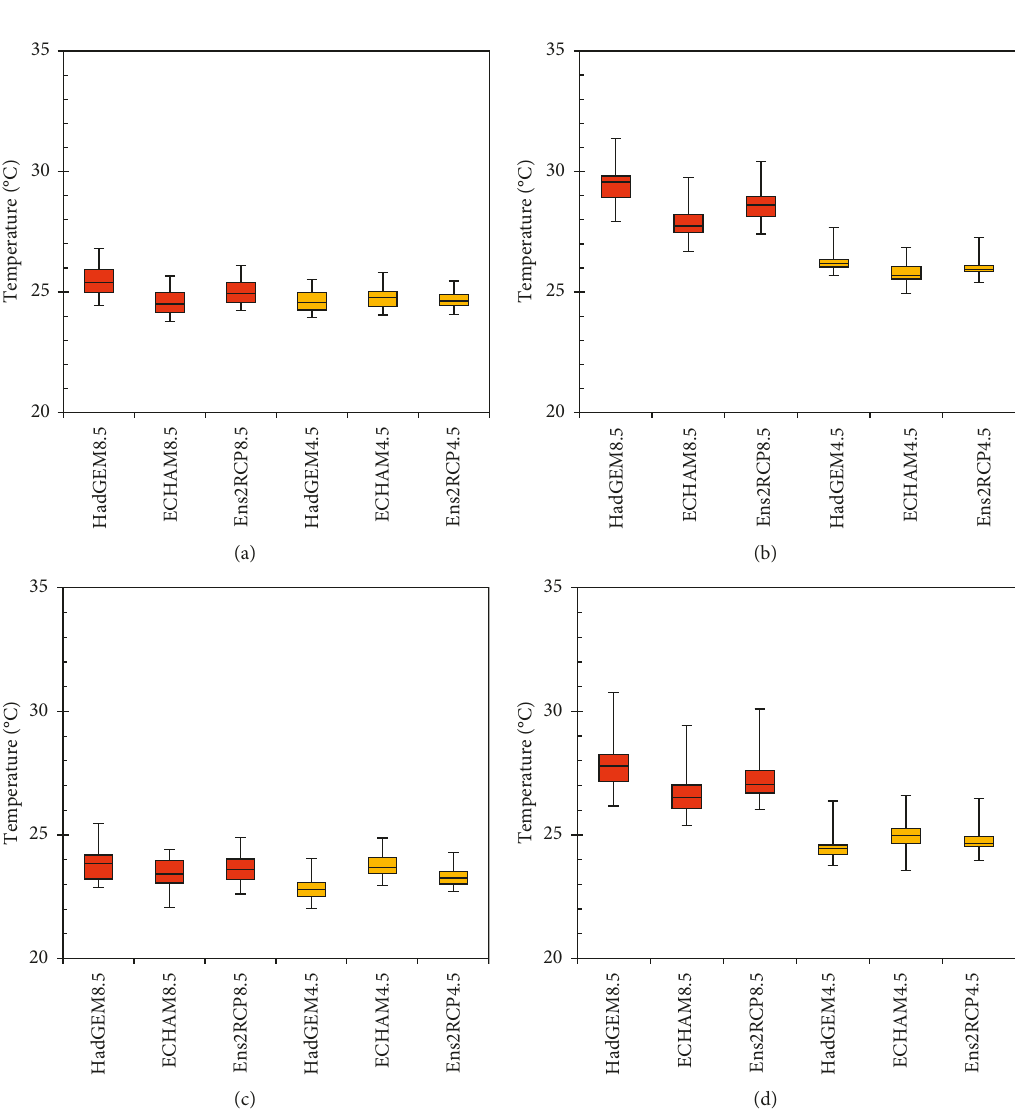
Figure 5: Box plots of RegCM4-simulated air temperature (in ° C) for each model and RCPs for near future and far future averaged over 11 subdomains for CORDEX-MENA/Arab domain (a, b) and subdomain over the Arabian Peninsula (c, d). The Ens2RCP8.5 and EnsRCP4.5 represent the average from HadGEM and ECHAM for the RCP8.5 and RCP4.5, respectively. The red boxes are for RCP8.5 and yellow boxes for